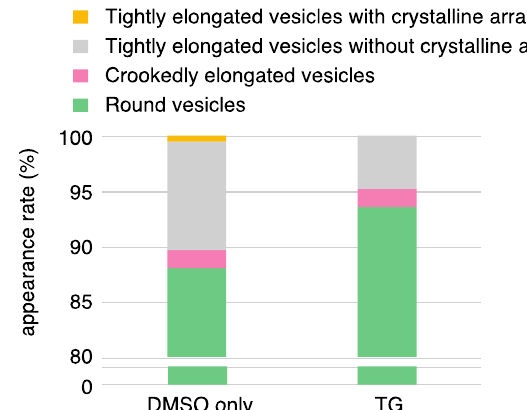
Figure 11. Bar plot showing the appearance rates of the various types of SR vesicle in samples with and without thapsigargin (TG). The rates are represented by the average percentages of the number of each vesicle type relative to the total number of vesicles. As indicated, the full range below 80% is not shown for the round vesicles, for convenience.